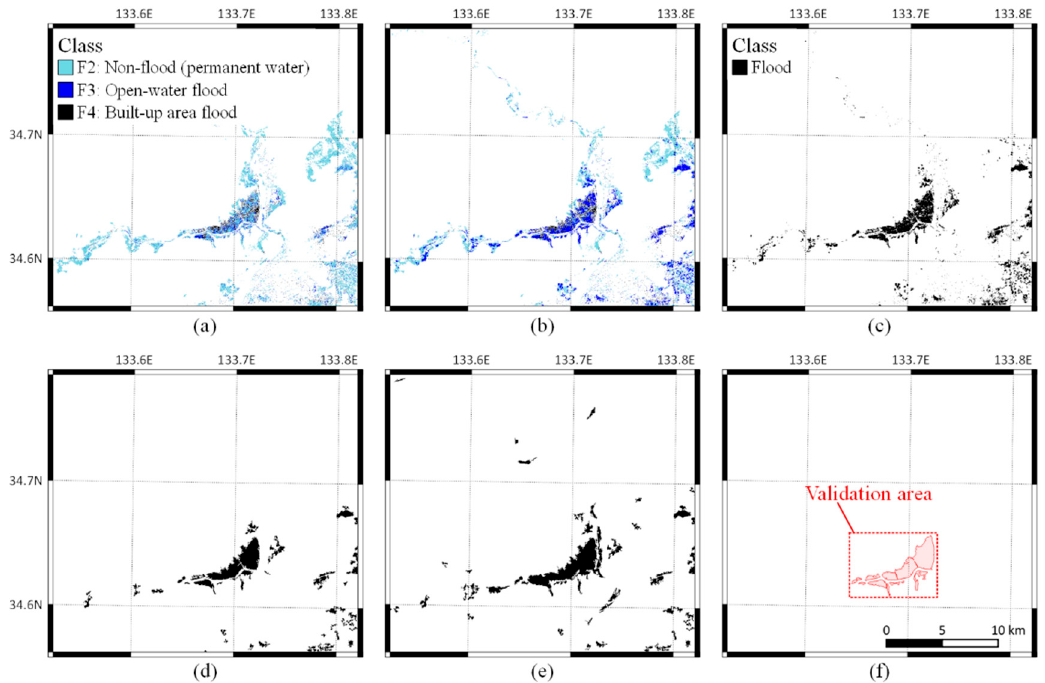
Figure 5. Step-by-step outputs of our method. ( a ) Initial classification map before the rice-paddy correction; ( b ) classification map after the rice-paddy correction; ( c ) polygonised flood area before simplification; ( d ) simplified flood-area polygon; ( a – d ) are results obtained using flood fraction (FLDFRC); ( e ) the result of the simplified polygon obtained without using FLDFRC; ( f ) reference data by GSI. Table 4 and Figure 6 summarize the flood detection accuracy and computation time for each case. Table 4. The accuracies of floods detected by ALOS-2 data, with and without flood simulation. Accuracy (Using Simulation) Accuracy (Without Simulation) O ff -Nadir Case Beamno. Angle No. Recall